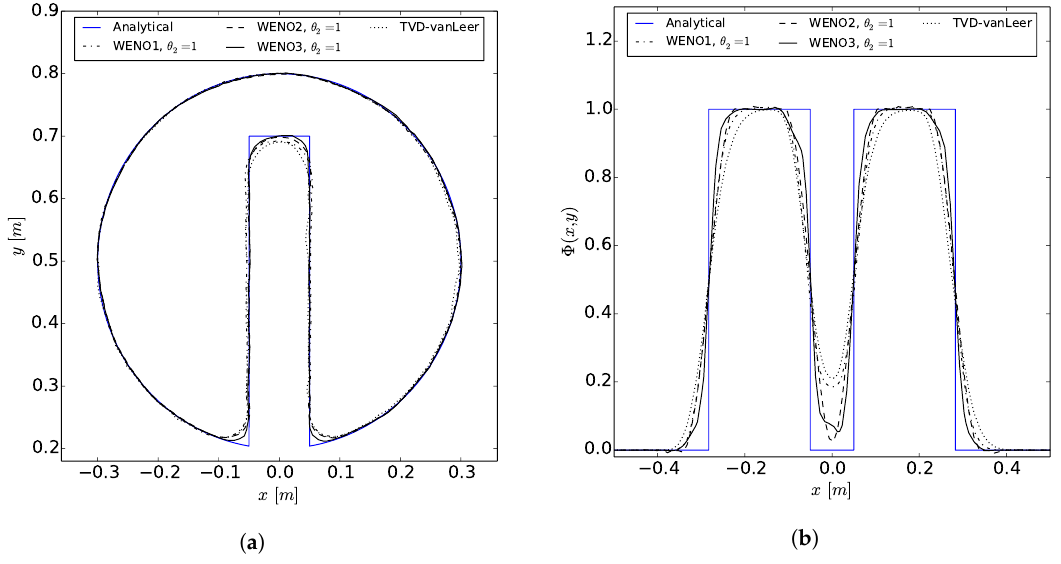
Figure 20. Results of convection schemes for Zalesak’s disk on 256 Φ = 0.5; ( b ) slice of the disk at y = 0.6